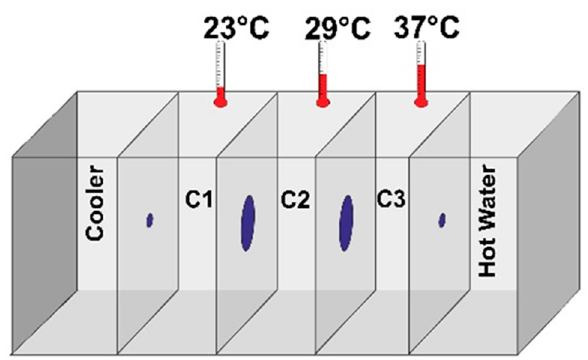
Figure 10. Schematic representation of the experimental tank setup with a variation of three temperature (23, 29 and 37 °C) gradient, interconnected chambers for studying behavioral fever in a study of